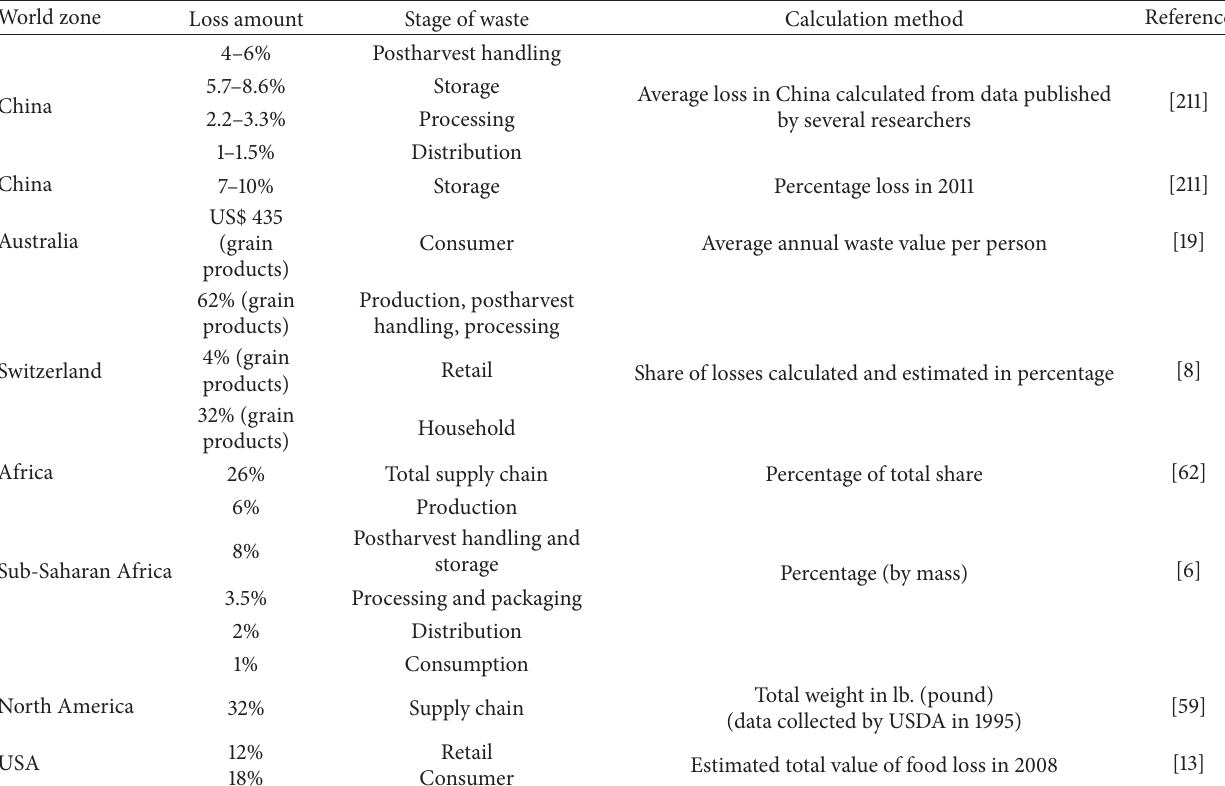
Table 5: Amount/percent/value of grain waste in selected world food supply